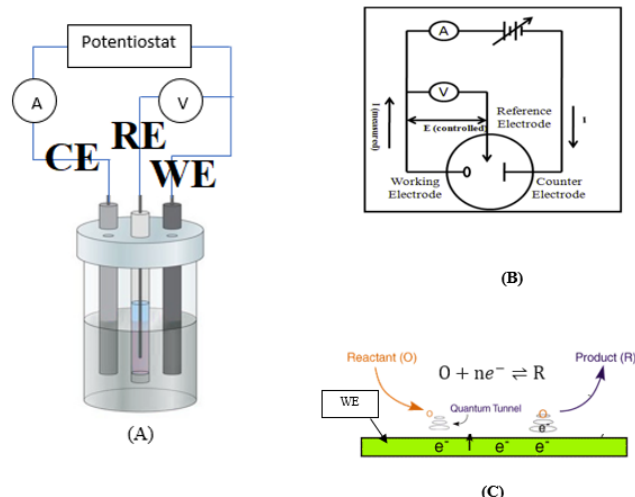
Figure 5. ( A ) A three-electrode cell with the utilization of cyclic voltammetry (CV) detection method— the input is the applied voltage while the output is the electrochemical analysis through the